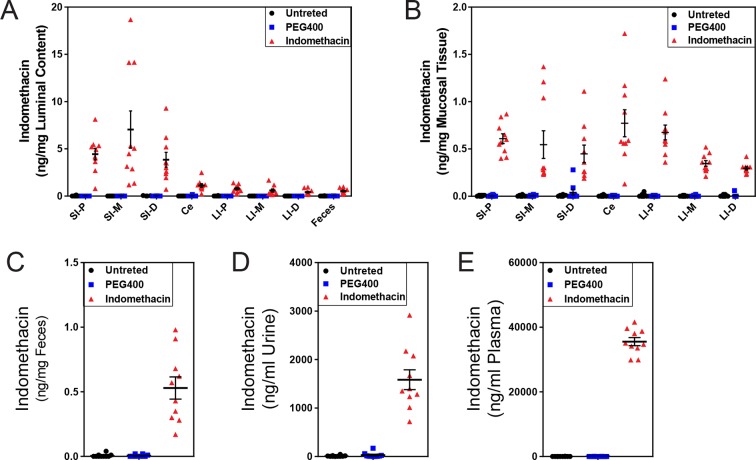
C57BL/6 mice are systemically and locally exposed to indomethacin.Mice were administered by gavage 10 mg/kg indomethacin in PEG400 (red) or PEG400 alone (blue). Urine, feces, plasma, and intestines were collected from mice at 6 hr after drug administration. Indomethacin concentrations were measured in samples and corrected by sample weight. Indomethacin is detected along the intestine in both luminal content (A) and mucosal tissue (B) in mice of indomethacin (red) group, but not in those of PEG400 (blue) or untreated (black) groups. In feces (C), urine (D), and plasma (E), indomethacin is also detected in mice of indomethacin (red) group, but not in those of PEG400 (blue) or untreated (black) groups. N=10/group. Mean ± S.E.M. shown. SI, small intestine; Ce, cecum; LI, large intestine. P, proximal; M, middle; D, distal.